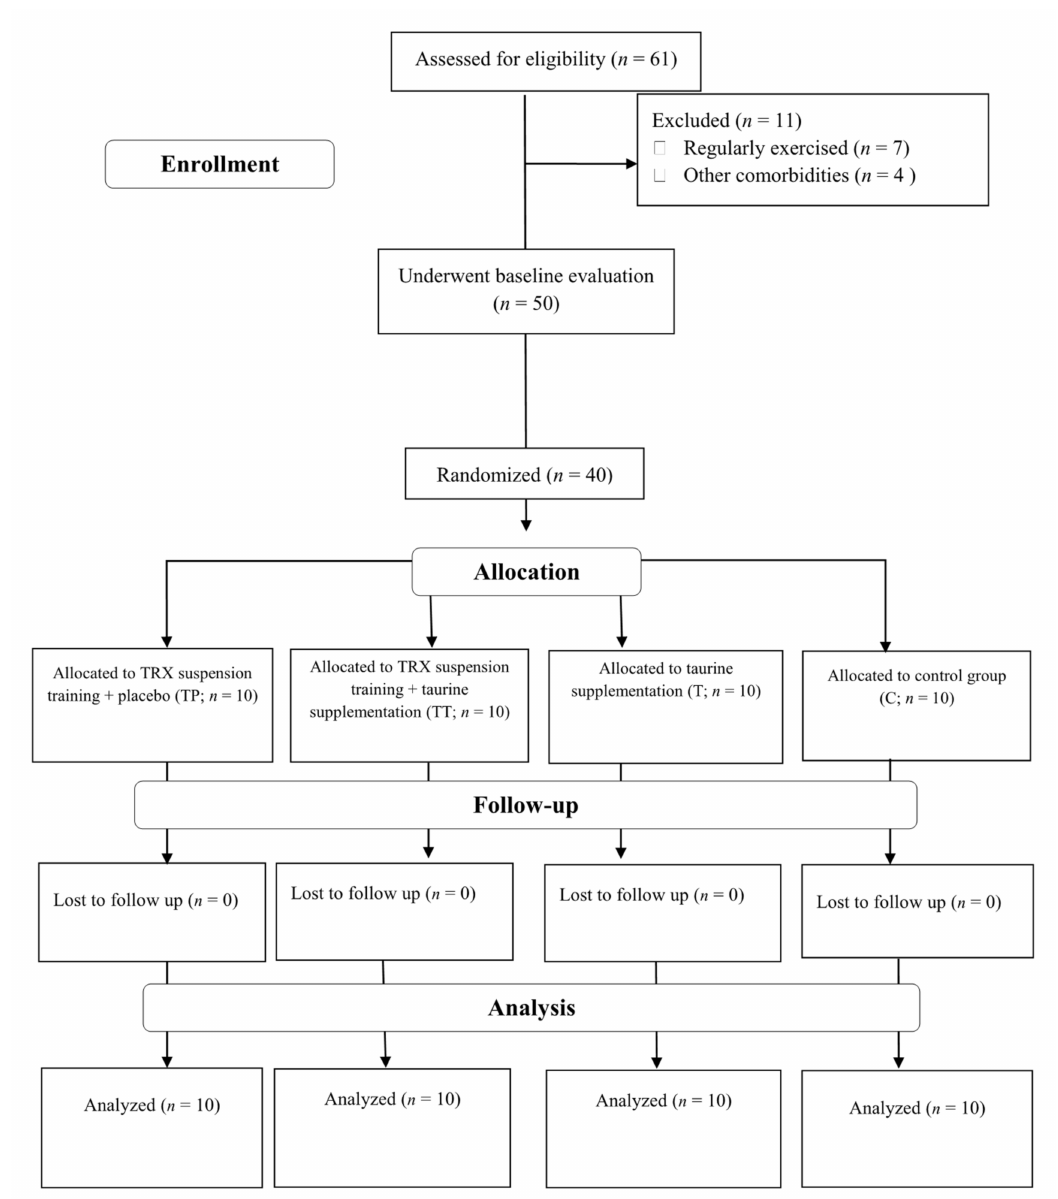
Figure 1. Participants Flow Diagram. Abbreviations: T, taurine supplementation; TP, TRX suspension training + placebo; TT, TRX suspension training + taurine supplementation; C,